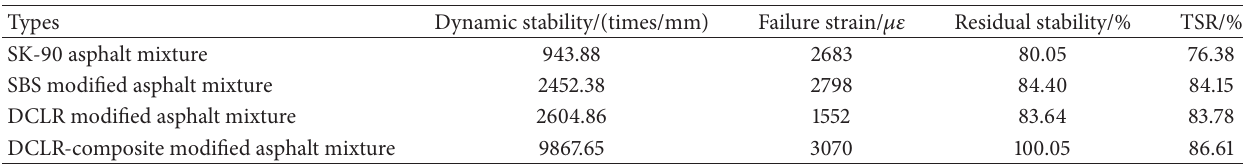
Table 7: Performance of the asphalt